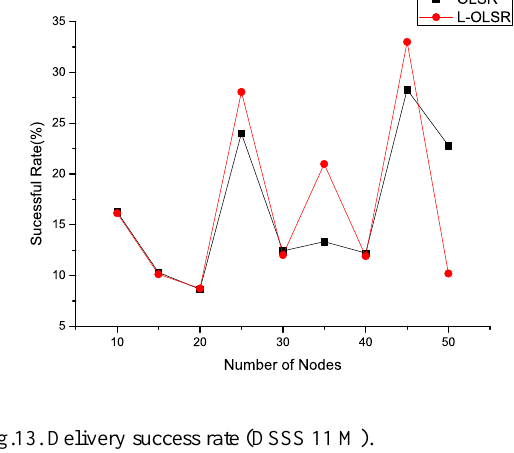
Fig.13. Delivery success rate (DSSS 11